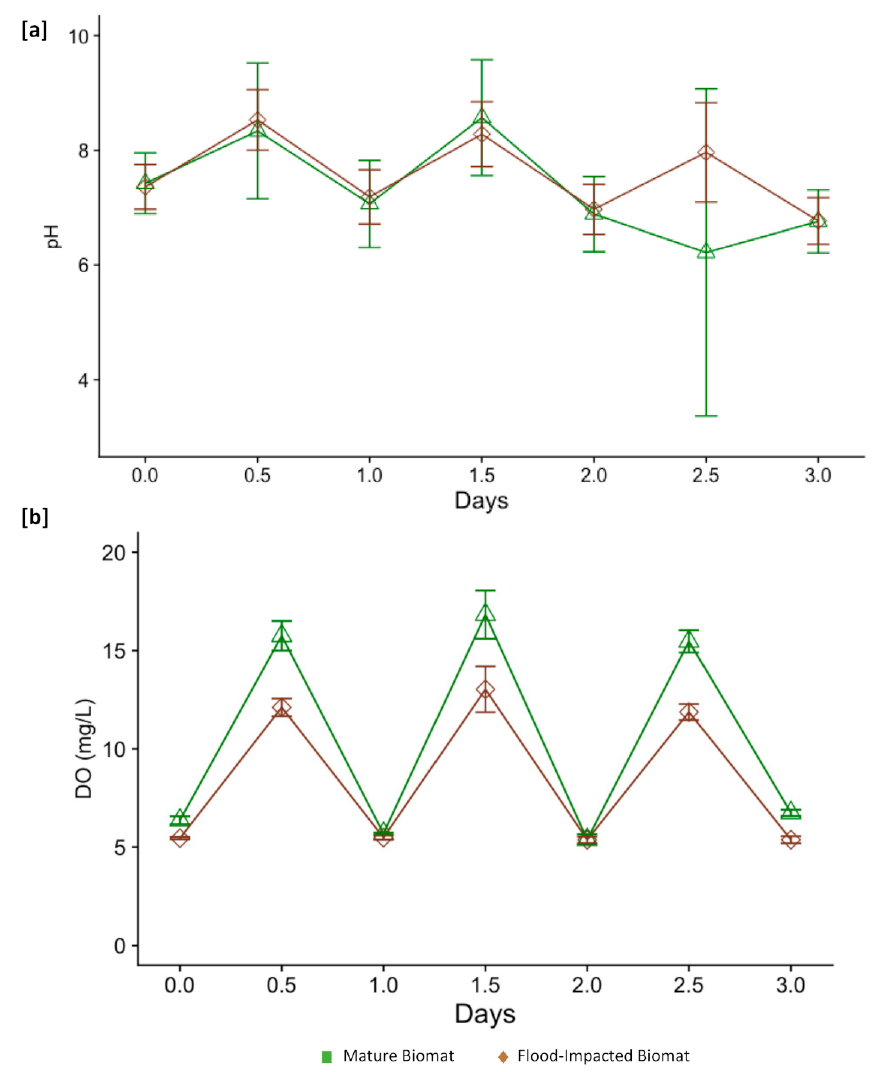
Figure 3. Comparison of diel indicators of photosynthesis, pH ( a ), and DO ( b ), between flood- impacted and mature biomat microcosms. Though the pH values in mature and flood-impacted biomat are similar, the DO levels in flood-impacted biomat are consistently lower, demonstrating a decreased level of biomat activity following a flooding event. Points represent the average of biological duplicates with error bars denoting maximum and minimum